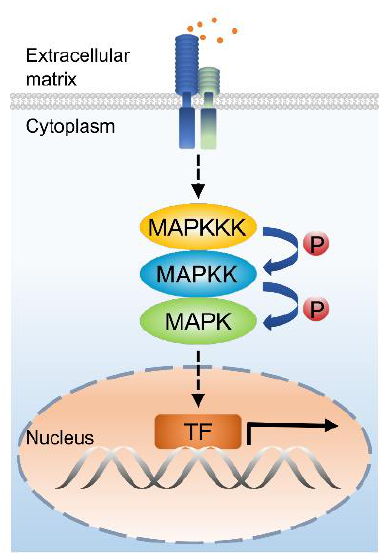
Figure 1. A general model of MAPK cascade functioning in plant development. A typical MAPK cascade contains three signaling components: a MAPK kinase kinase (MAPKKK), a MAPK kinase (MAPKK), and a MAPK. The MAPK cascade is activated by upstream regulators and transduces the signal to downstream transcription factors in the nucleus via sequential phosphorylation. The red dots represent extracellular signals that can be perceived by membrane-anchored receptors. The black arrow indicates gene expression. P, phosphorylation relay. TF, transcription factor.